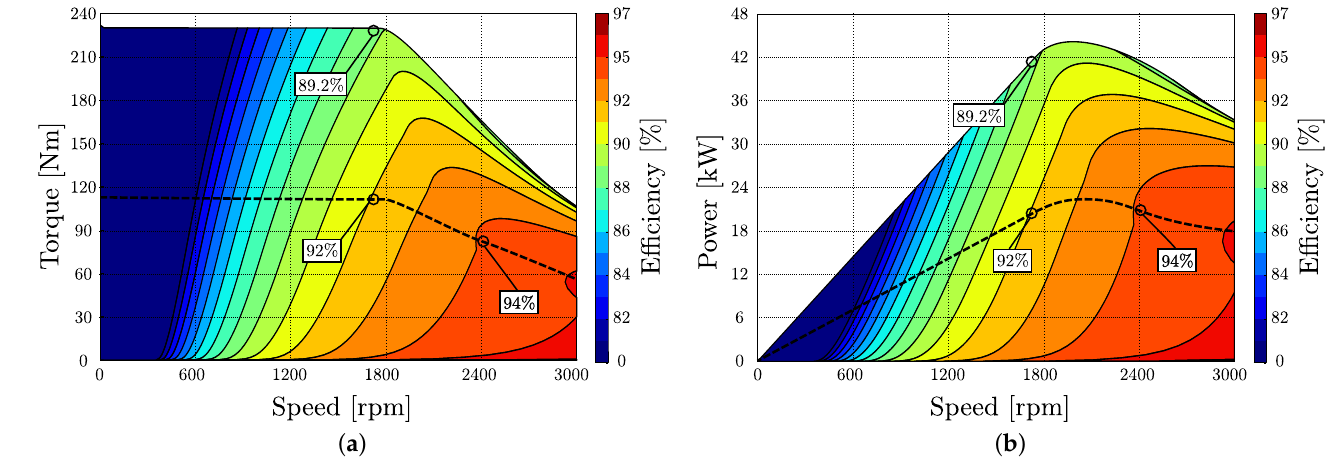
Figure 18. MZhVD efficiency relative to the ( a ) torque-speed and ( b ) power-speed